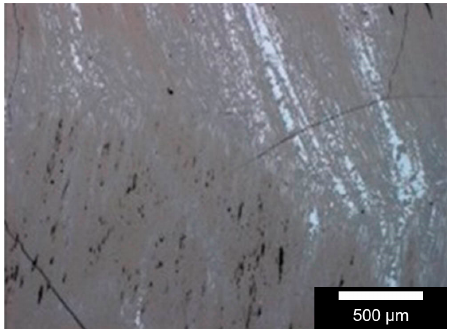
Figure 1. Surface-analysis of carbon fibre-reinforced silicon carbide (C/SiSiC)-cubes. White-light interferometric images 50×. Pale grey = silicon; dark grey = silicon carbide; black = carbon fibres or pores, or breaks that occurred before sample preparation. Table 1. Material properties of C/SiSiC.